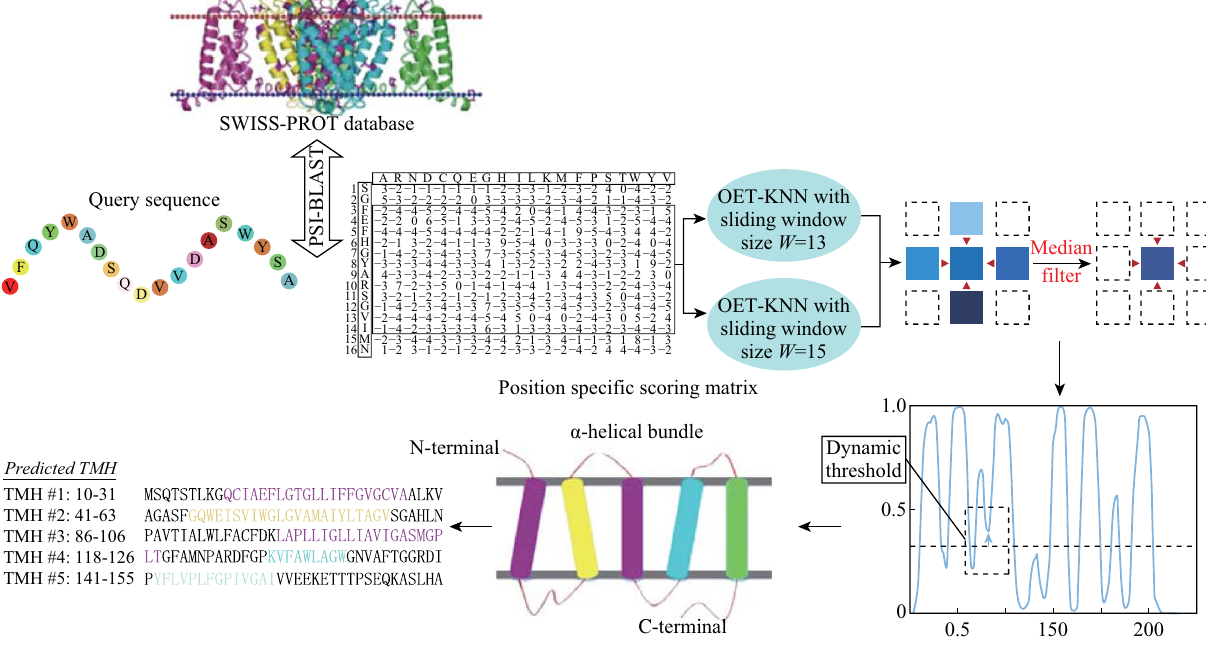
Fig. 3 The pipeline of MemBrain for predicting transmembrane a -helices. For a query sequence, we generate the position specific scoring matrix as input features by searching against SWISS-PROT database using the PSI-BLAST tool. The OET-KNN algorithm is employed as the classifier with fused different sizes of sliding window for extracting features. Median filter is applied to smooth the profile of predicted probabilities. Finally, the dynamic threshold is effectively used to optimize the results of